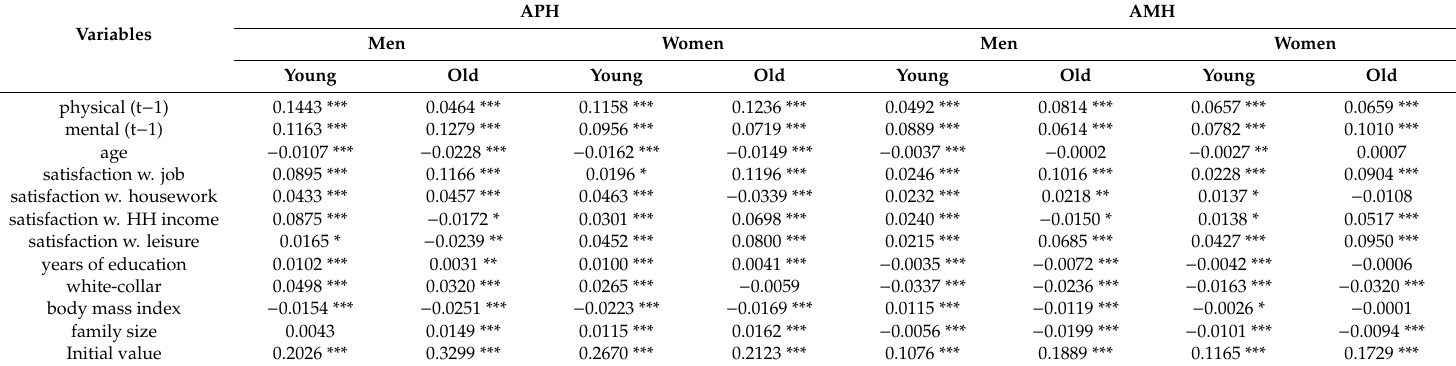
Table 9. Estimation results: average partial e ff ects of aggregate level in small